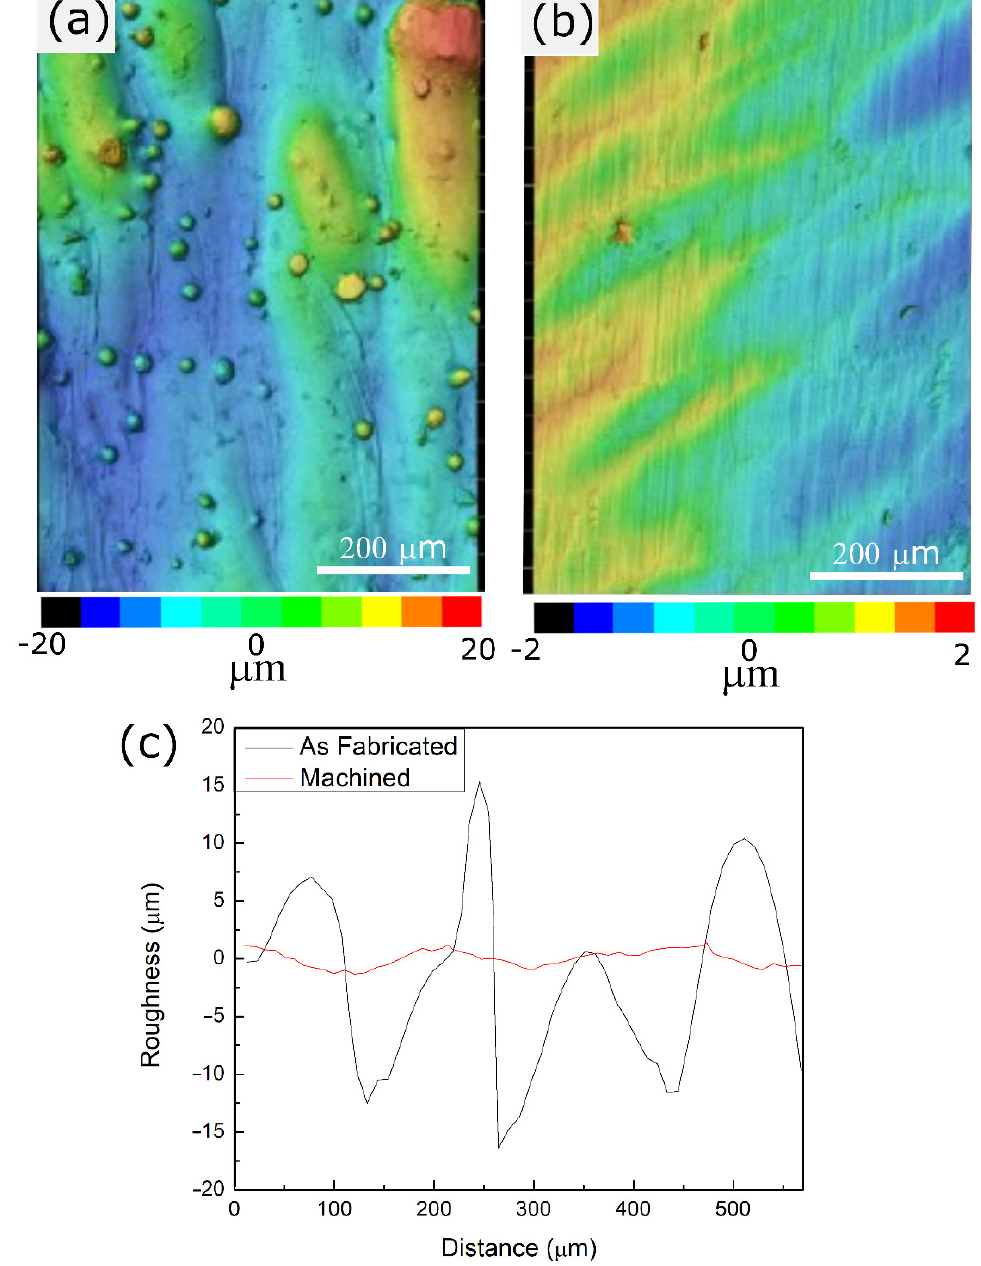
Figure 3. Surface topography characterization: ( a ) 2D surface profile of an as-built surface, ( b ) 2D surface profile of a machined surface, and ( c ) comparison of surface line profiles of as-built and machined surfaces.